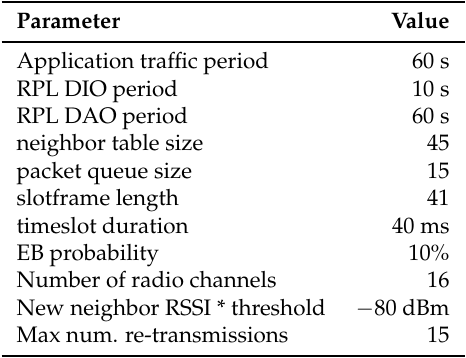
Table 2. Parameters of the OpenWSN protocol